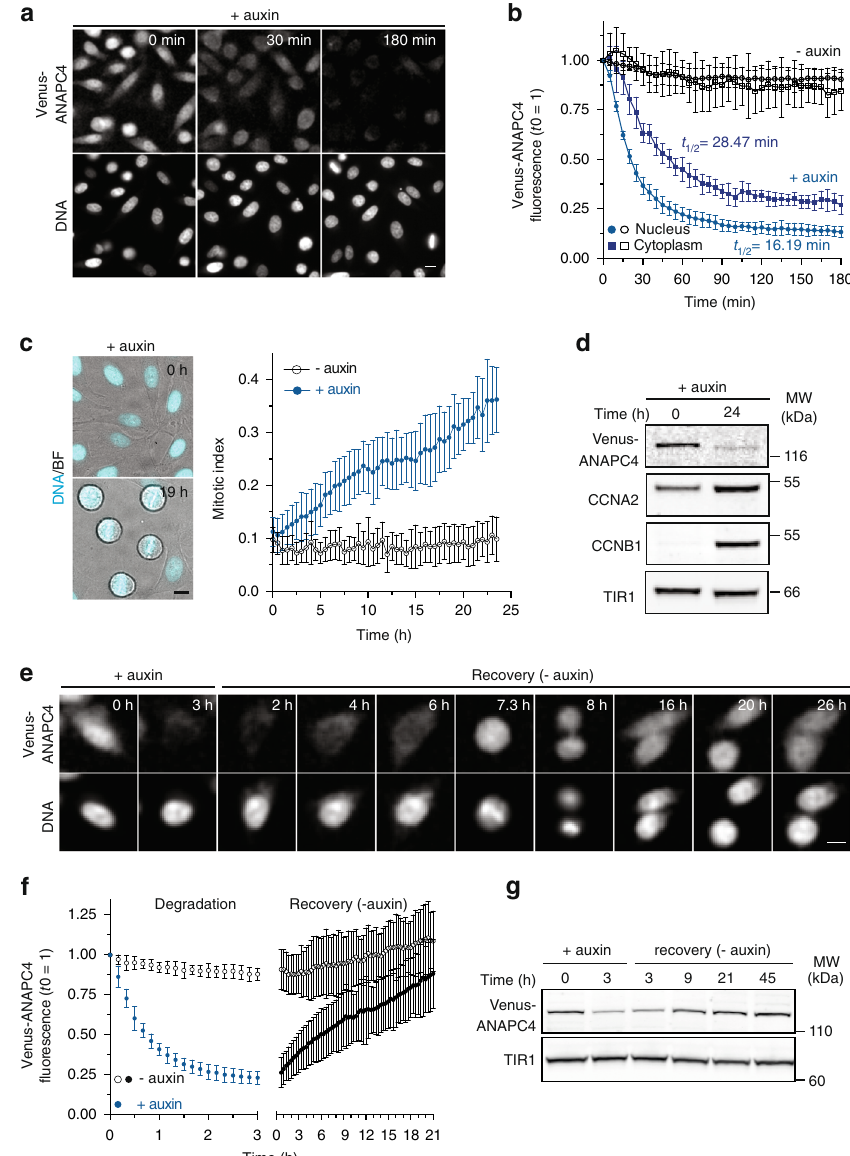
Fig. 4 mAID-nanobodies allow the rapid but reversible inactivation of the APC/C. a Degradation of endogenously tagged Venus-ANAPC4 after the addition of 0.5 mM auxin. Scale bar: 10 μ m. ANAPC4, APC/C subunit 4. See also Supplementary Figure 3 for characterization of the ANAPC4 knock-in. b Quanti fi cation of Venus-ANAPC4 fl uorescence from time-lapse data in a showing the kinetics of Venus-ANAPC4 degradation in the nucleus and cytoplasm represented as the mean ± s.d. ( n = 6, all conditions). c Time-lapse images and quanti fi cation of Venus-ANAPC4 cells arresting in mitosis in the presence of 0.5 mM auxin. Data represent the mean ± s.d. ( n = 12, − auxin and + auxin). Scale bar: 10 μ m. d Western blot analysis of cells treated with 0.5 mM auxin for the indicated time. Accumulation of cyclins CCNA2 and CCNB1 are indicative of a mitotic arrest. TIR1 serves as a loading control. e Time- lapse images of Venus-ANAPC4 cells treated for 3 h with 0.5 mM auxin followed by auxin removal and 26 h of recovery. Note, Venus-ANAPC4 recovery after 7.3 h is suf fi cient to allow mitotic progression. Scale bar: 10 μ m. f Quanti fi cation of Venus-ANAPC4 recovery from cells treated as in e represented as mean ± s.d. ( n = 18, − auxin; n = 39, + auxin). Scale bar: 10 μ m. g Western blot analysis of cells treated as in e , TIR1 serves as a loading